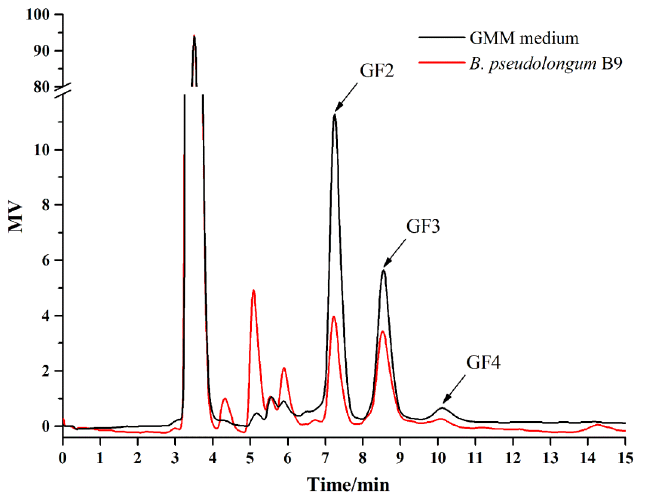
Figure 6. High performance liquid chromatography (HPLC) analysis of the supernatant for B. pseudolongum (B9) in Gut Microbiota Medium (GMM) – FOS medium. GF2, GF3, and GF4 were the main components of